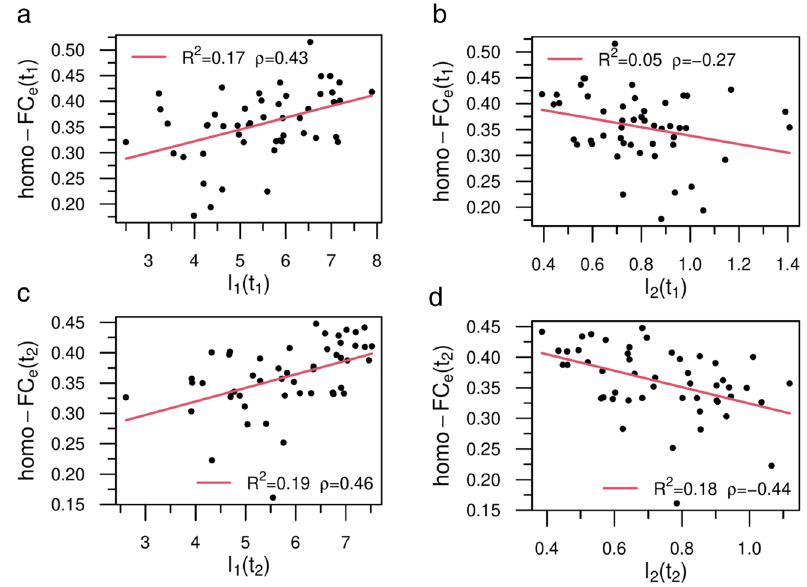
Fig. 7 Statistical correlates between model dynamical patterns and empirical homotopic functional connectivity. In the legend we show the (linear) correlation, ρ and the R 2 . a , c Relationship between I 1 and empirical homo-F C e at t 1 and t 2 , respectively. b , d The same as before, but for I 2 . Both dynamical variables predicted a signi fi cant amount of functional variance, but panel b did not remain signi fi cant after correcting at level of α = 0.05. Sample size ( n = 50). Source data are provided as a Source Data fi